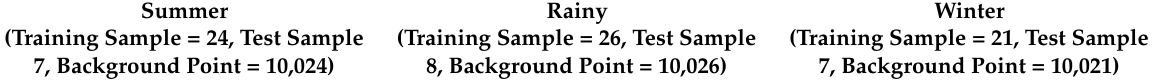
Table 1. Suitable habitat analysis for the summer season, the rainy season, and the winter season by using MaxEnt and population home ranges by using the Minimum Convex Polygon (95 % MCP) and the Kernel Density Estimate (95% KDE) for eastern sarus cranes ( Antigone antigone sharpii ) in Ayeyarwady Delta, the Union of Myanmar.